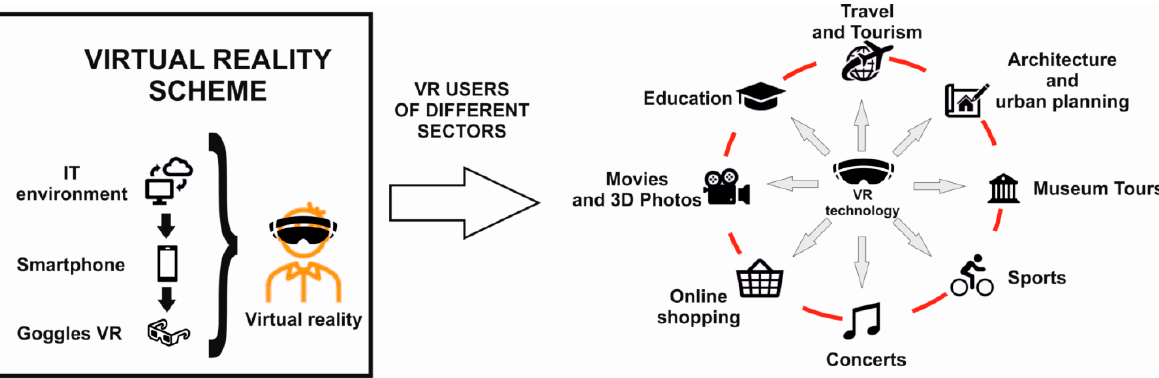
Figure 4. Operational diagram for virtual reality and its areas of application. Source: prepared by the author.